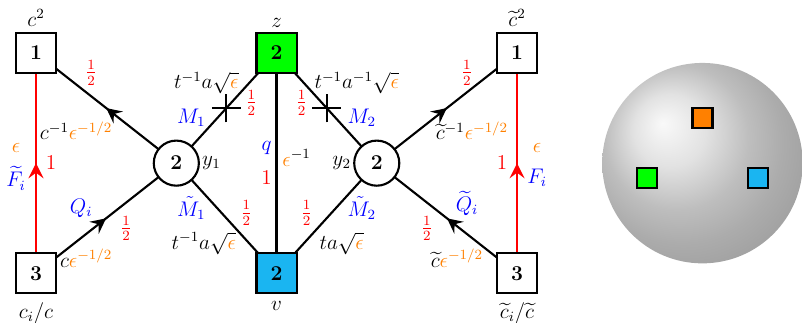
Figure 7: Quiver of A 1 trinion theory. This trinion is obtained by compactifying the E- 1 string on a sphere with certain choice of three punctures and vanishing flux. Crosses on lines stand for gauge singlet chiral fields flipping a quadratic gauge invariant built from the field they cross out. All fields charged under SU ( 2 ) gauge symmetries have R -charge 1 while the gauge singlets have R -charge 1. Red lines as usually stand for 2 the contributions of flip singlets F and ˜ F . In our notations blue corresponds to the i i names of the fields, red to the fugacities of gauge and global symmetries and black to the U ( 1 ) charges of the fields. We also write ε in orange denoting the SU ( 2 ) ε global symmetry of the corresponding type puncture that is not present explicitly and only arises in the IR. Types of two other punctures are denoted in blue and green. For the ) 1 / 3 . For convenience ) 1 / 3 and ˜ c = ( ˜ c c c ˜ c ˜ c fugacities we also use notation c = ( c 3 2 1 2 3 1 = c − 3 and ˜ c = ˜ c − 3 in the text we will instead use fugacities c 4 4